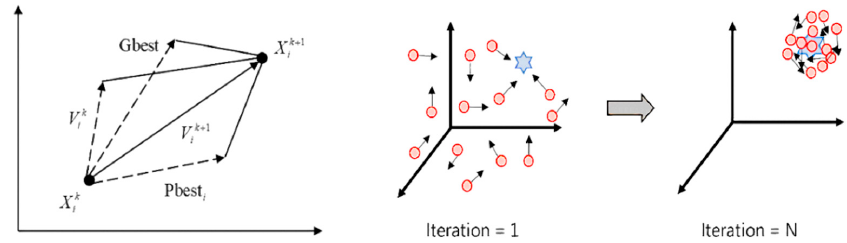
Figure A1. Particle swarm optimization.